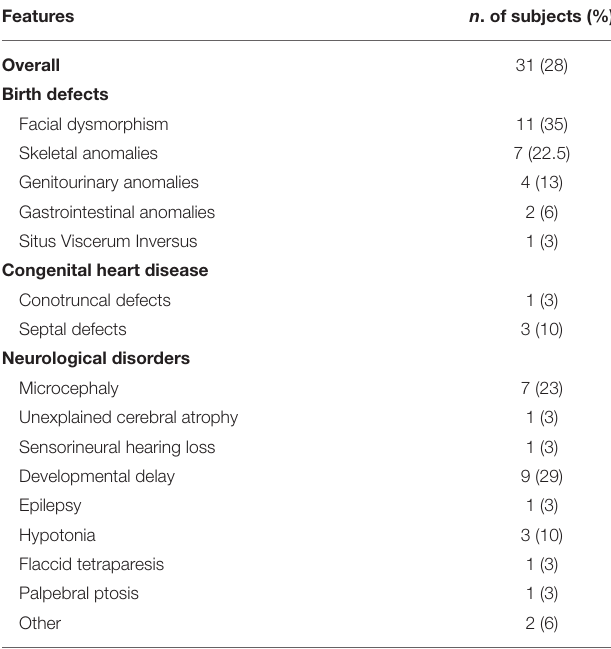
TABLE 3 | Extra-immunological features of the SCID